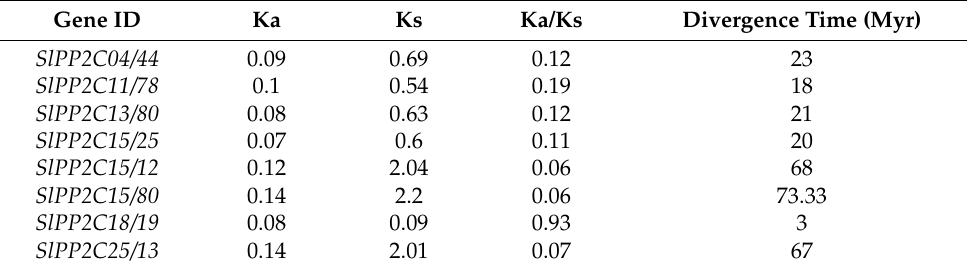
Figure 2. Duplication event analysis of SlPP2C genes and comparative synteny analysis among tomato, Arabidopsis, and rice, between tomato and Arabidopsis, and between tomato and rice. The red line represents the syntenic gene pairs between rice and Arabidopsis. The blue line indicates the syntenic gene pairs between rice and tomato. The green line represents the syntenic gene pairs between tomato and Arabidopsis. The golden line represents the syntenic gene pairs in tomato. The yellow line represents the syntenic gene pairs in Arabidopsis. The purple line represents the syntenic gene pairs in rice. Tomato chromosomes are depicted as green segments, and Arabidopsis and rice are shown in red and orange, respectively. The chromosome number and syntenic gene pairs are marked. The size of chromosomes was consistent with the actual pseudo-chromosome size. Positions are in Mb. Table 3. SlPP2C syntenic gene pairs present in tomato genome.